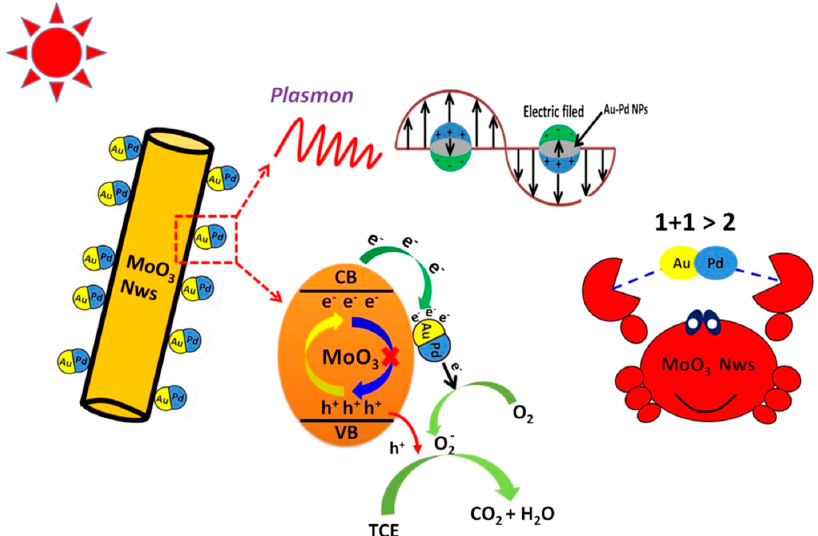
Figure 19. Schematic illustrating the band structure of MoO 3 /Au-Pd composite photocatalyst and the possible reaction mechanism. Adapted with permission from Reference [98]. Copyright (2018) Elsevier.